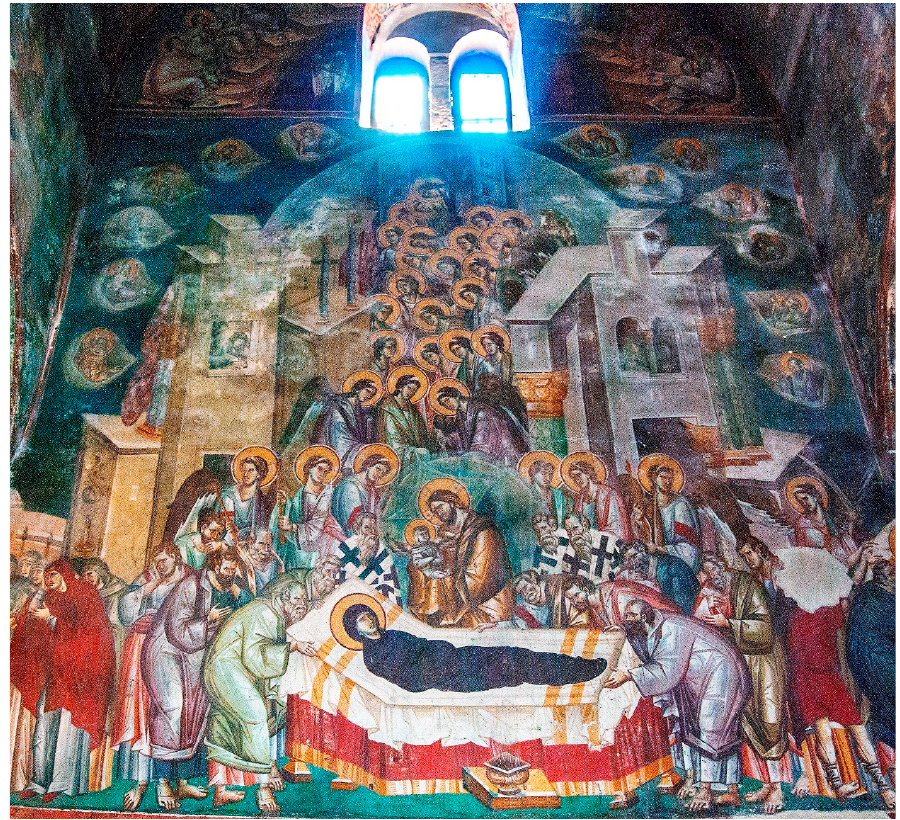
Figure 4. Dormition of the Theotokos , wall painting, 1294/5, Church of the Holy Mother of God Peri- bleptos, Ohrid, Republic of North Macedonia. (Photo credit: Angel Yordanov, TerraByzantica